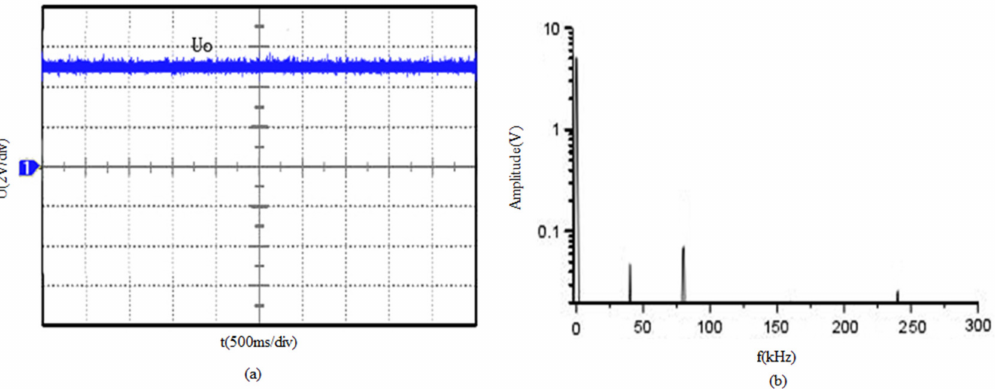
Figure 24. Experimental voltage waveforms of the DC power generation: ( a ) output voltage waveform; ( b ) output voltage